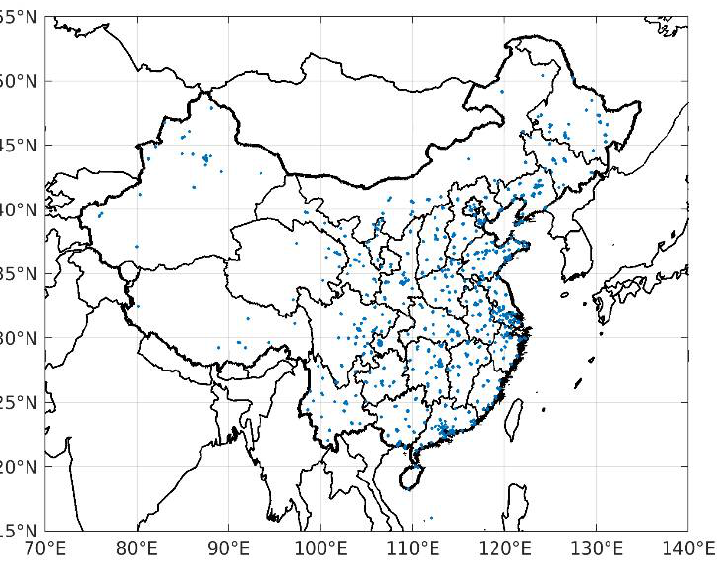
Figure A1. Location of 1643 environmental monitoring stations of the China National Environmental Monitoring Center operated by the Ministry of Ecology and Environmental Protection of China. The data is available at http://106.37.208.233:20035 (accessed on 21 July 2021) [48]. Data quality control has been applied to the measurements following [49]. To allow meaningful comparisons between the in situ NO2 data and the TROPOMI columns, we considered only in situ data within a two-hour time-window around the TROPOMI overpass time (12–2 p.m. local